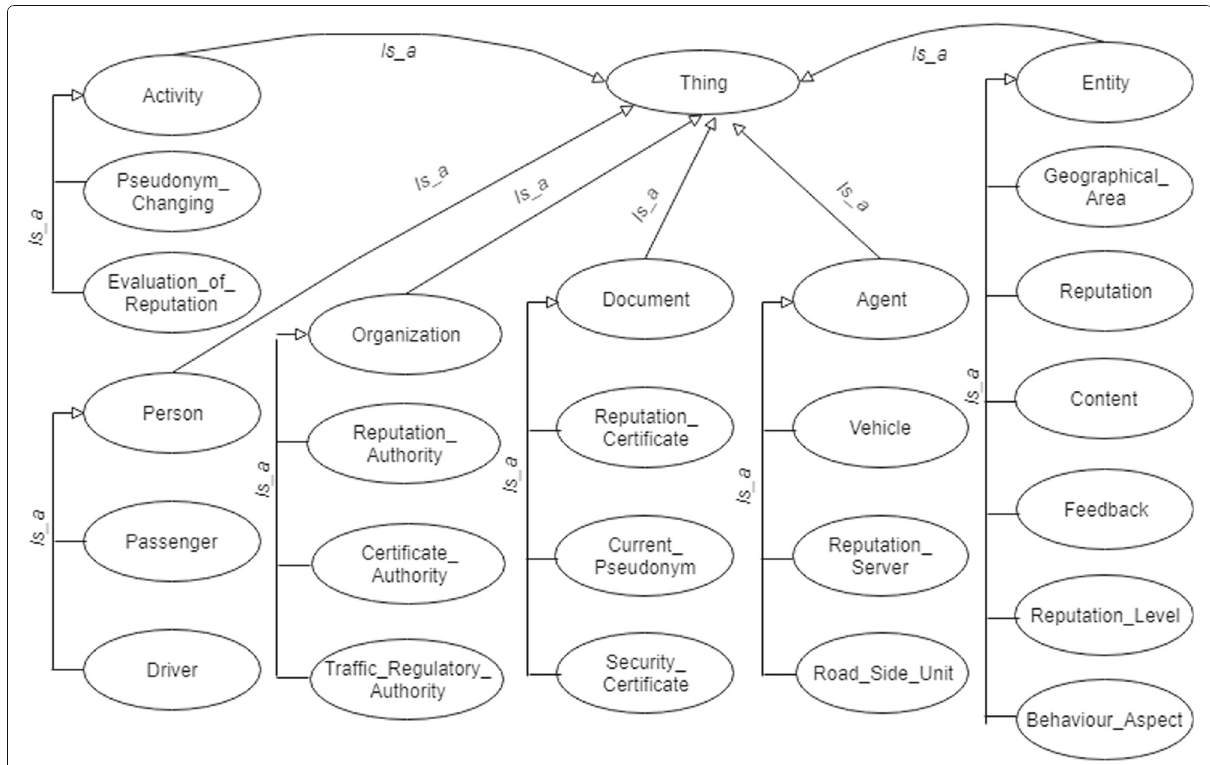
Fig. 2 First three layers of a possible functional ontology